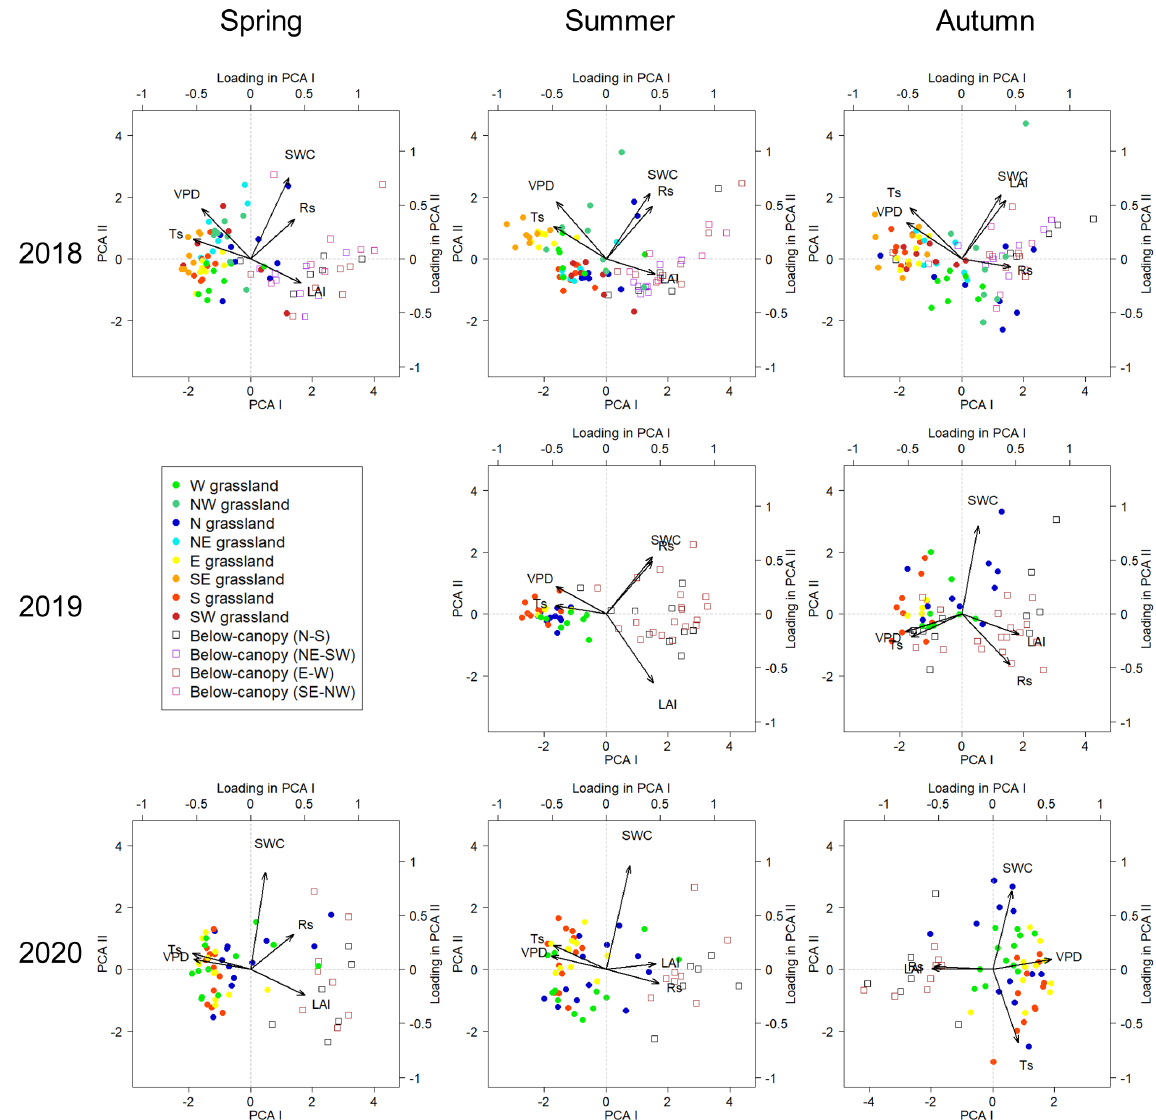
Figure 5. PCA biplots of the measurement campaigns with separation of the measuring positions below (open square symbols) and surround- ing (closed spots with cold–warm colors according to the cardinal directions) the groves. Variables: soil respiration ( R s ), soil water content (SWC), leaf area index (LAI), soil temperature ( T s ) and vapor pressure deficit (VPD). Cardinal directions: west (W), northwest (NW), north (N), northeast (NE), east (E), southeast (SE), south (S) and southwest